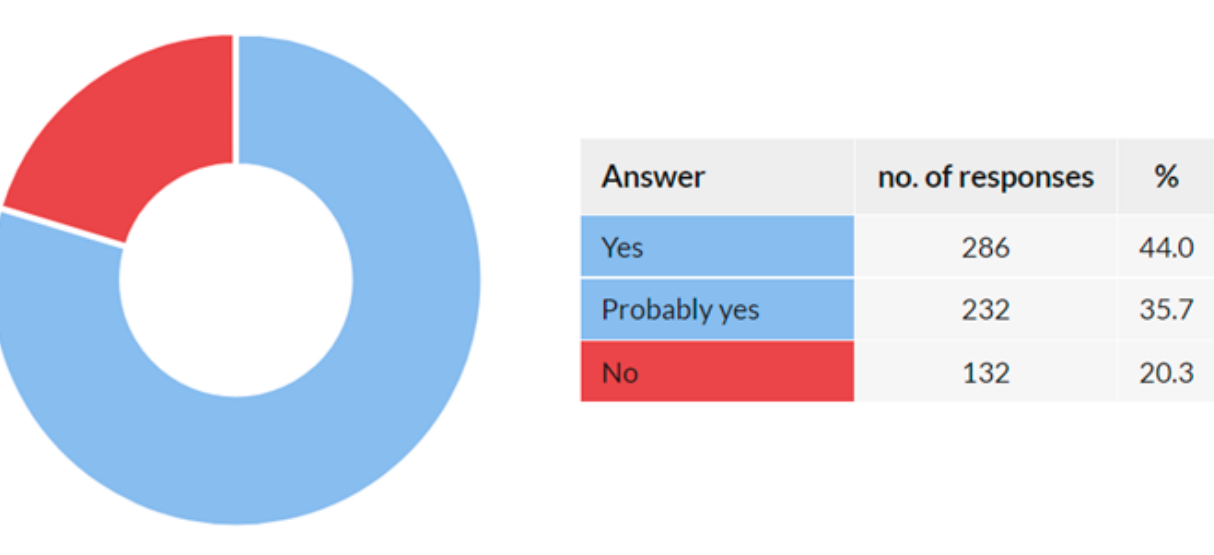
Figure 11. Awareness of where the infection occurred.